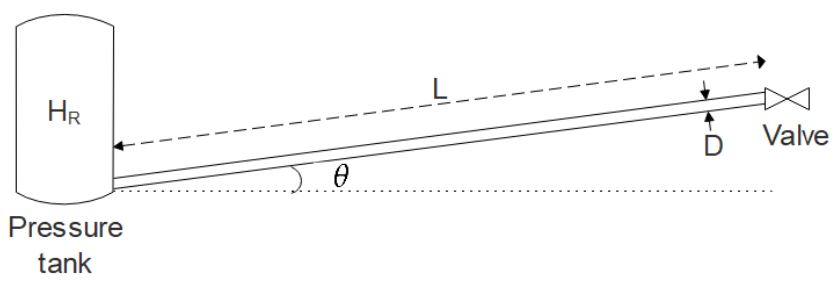
Figure 4. Typical experimental setup